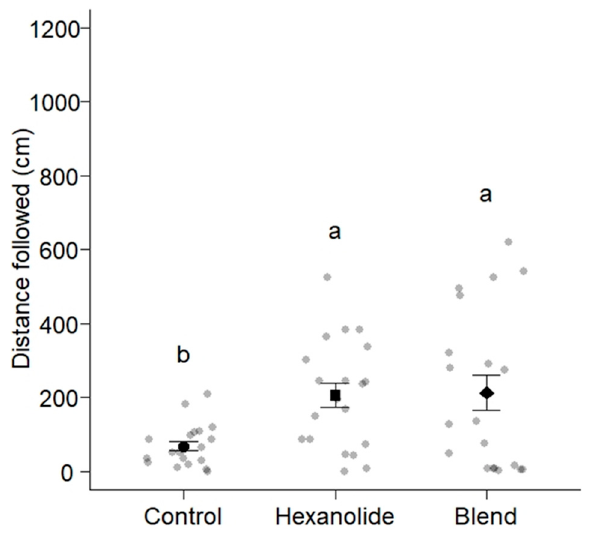
Figure 4. Distances worker ants of Camponotus modoc (n = 60) travelled following trails of synthetic (2 S ,4 R ,5 S )-2,4-dimethyl-5-hexanolide (the known trail pheromone of Ca. modoc [16]), a six-trail- pheromone blend (Table 1), and a solvent control applied to the circumference of a circular filter paper (diam: 185 mm) marked in 1 cm intervals (Figure 1). Grey and black symbols show the distance that each ant and 20 ants on average (mean ± whiskers) travelled, respectively, following trails. Means associated with different letters are statistically different (Tukey’s honest significant difference (HSD) test, p < 0.01); two out of 62 ants tested did not enter the bioassay arena and were excluded from this data set. There were no significant differences in the distances that worker ants of M. rubra travelled following trails of the 6-TPB (22.9 ± 8.7 cm), the 3-ethyl-2,5-dimethylpyrazine (41.2 ± 8.3 cm), and the solvent control (32.9 ± 8.1 cm) (ANOVA, F = 1.1555, df = 2, residual df = 57, p = 0.3222; Figure 5). Figure 5. Distances worker ants of Myrmica rubra (n = 60) travelled following trails of synthetic 3- ethyl-2,5-dimethylpyrazine (the known trail pheromone of M . rubra [19]), a six-trail-pheromone blend (Table 1), and a solvent control applied to the circumference of a circular filter paper (diam: 90 mm) marked in 1-cm intervals (Figure 1). Grey and black symbols show the distance that each ant and 20 ants on average (mean ± whiskers) travelled, respectively, following trails. Means associated with different letters are statistically different (Tukey’s honest significant difference (HSD) test, p < 0.01).